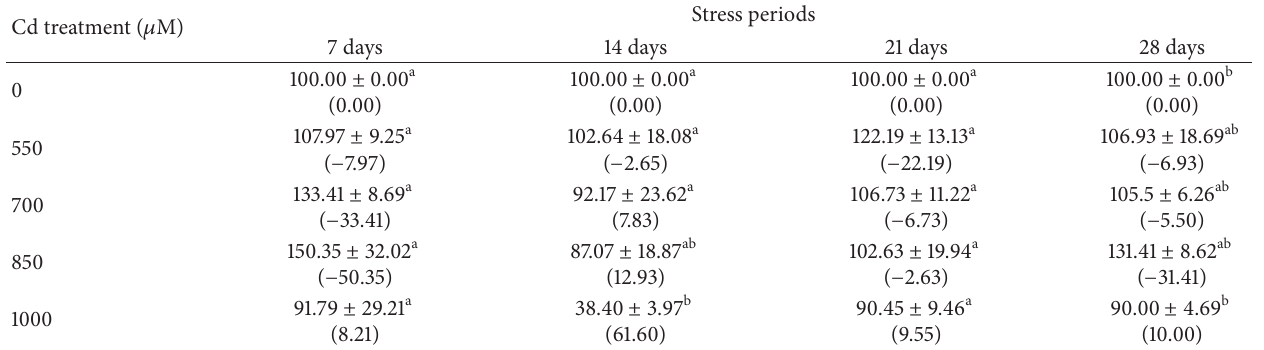
Table 2: Percent tolerance index of cotton callus culture (cv. YZ1) grown under various levels of cadmium. Cd treatment ( 𝜇 M)